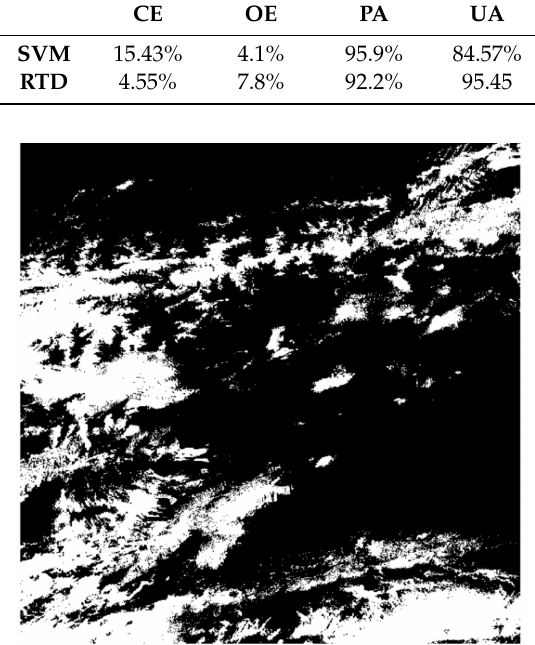
Figure 12. The results of the spectral test of the RTD method in